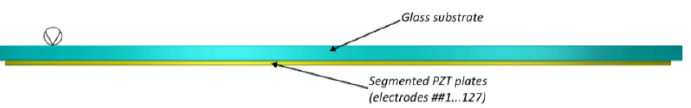
Figure 1. Design of the bimorph deformable mirror (##—numbers of the electrodes).